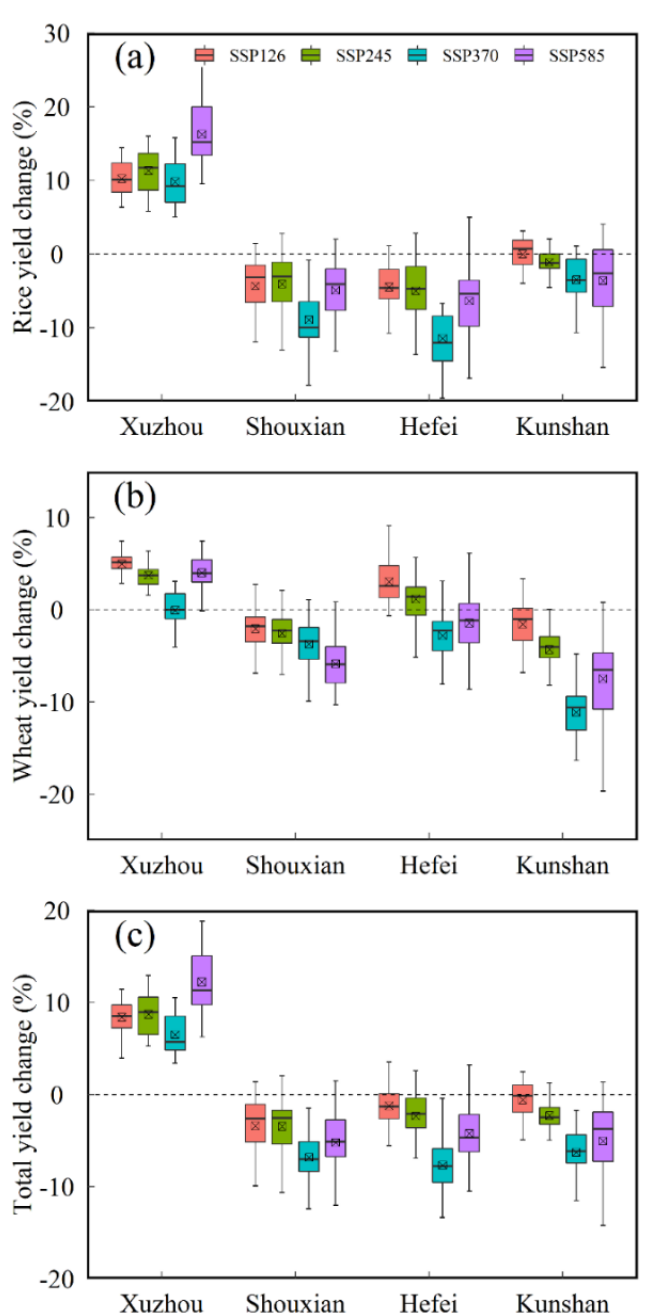
Figure 5. Projected changes in yield for rice ( a ), wheat ( b ), and total of rice and wheat ( c ) in the 2050s (2041–2070) period under SSP126, SSP245, SSP370, and SSP585 compared to the baseline period (1981–2010) across the 22 CMIP6 GCMs in the four agro-meteorological stations. The yield change for rice under future scenarios at Xuzhou station increased by 9.8–16.3%, while the decline magnitude of rice yield in the 2050s at Shouxian, Hefei,